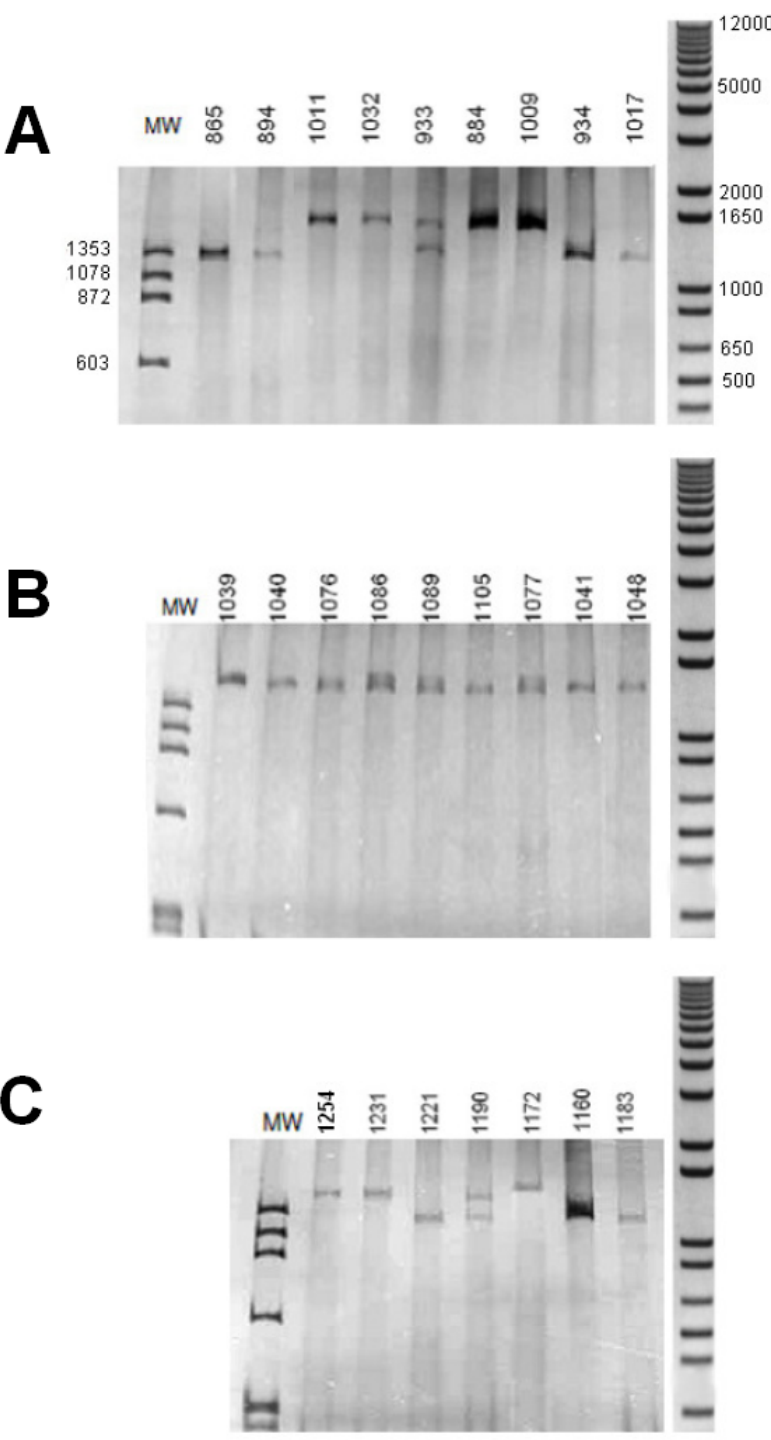
Figure 2. Polyacrylamide gel electrophoresis with silver stain. Amplification of intron 2 of the myoglobin gene. ( A ) B. glabrata ; ( B ) B. straminea ; ( C ) B. tenagophila . Numbers above the lanes indicate one different individual. MW = molecular weight (base pairs) of  X174/ Hae III digested (Amersham Biosciences). Right: molecular weight (base pairs) of 1 kb Plus DNA ladder